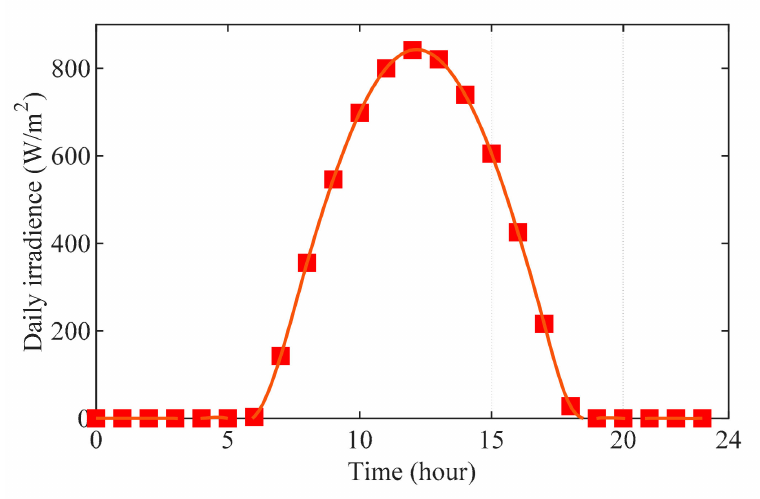
Figure 2. Hourly distribution of solar irradiance on 1 October